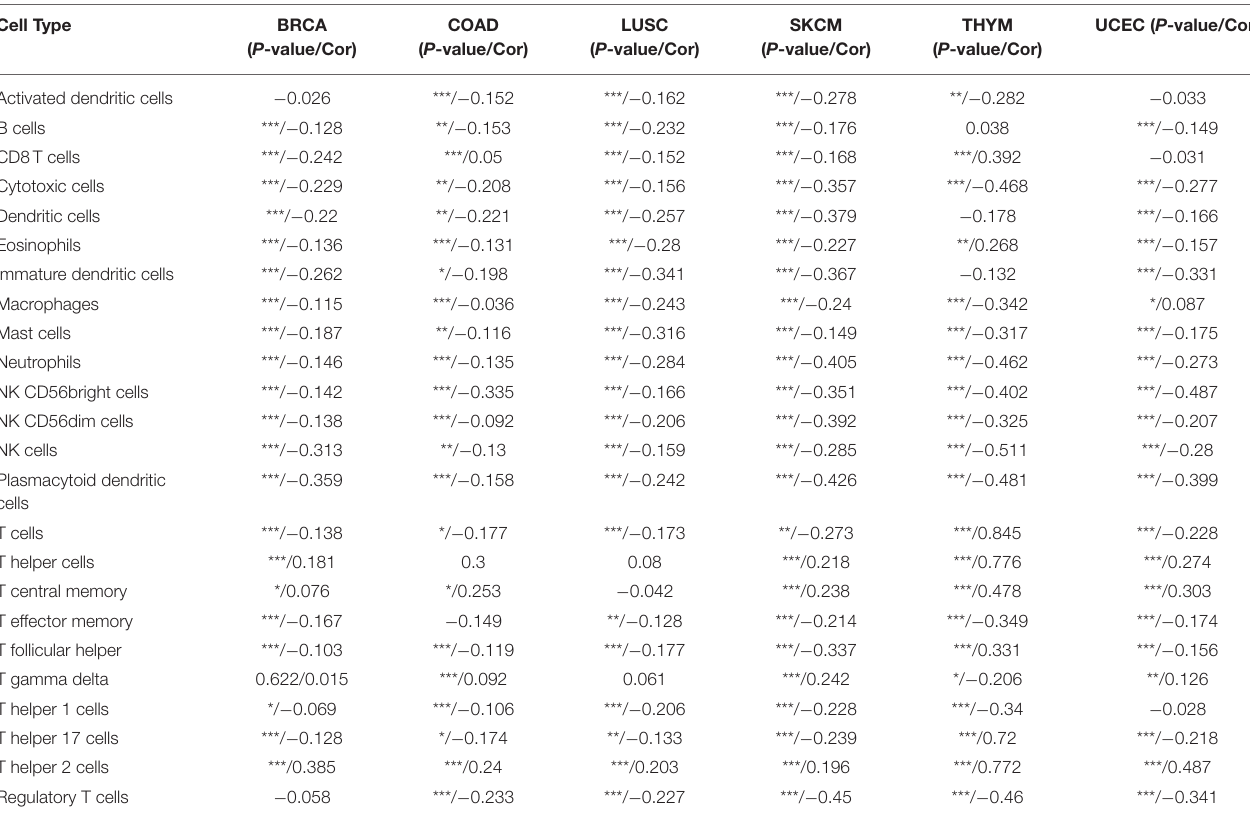
TABLE 1 | The link between the expression of CBX3 and immune cell infiltration of various types of